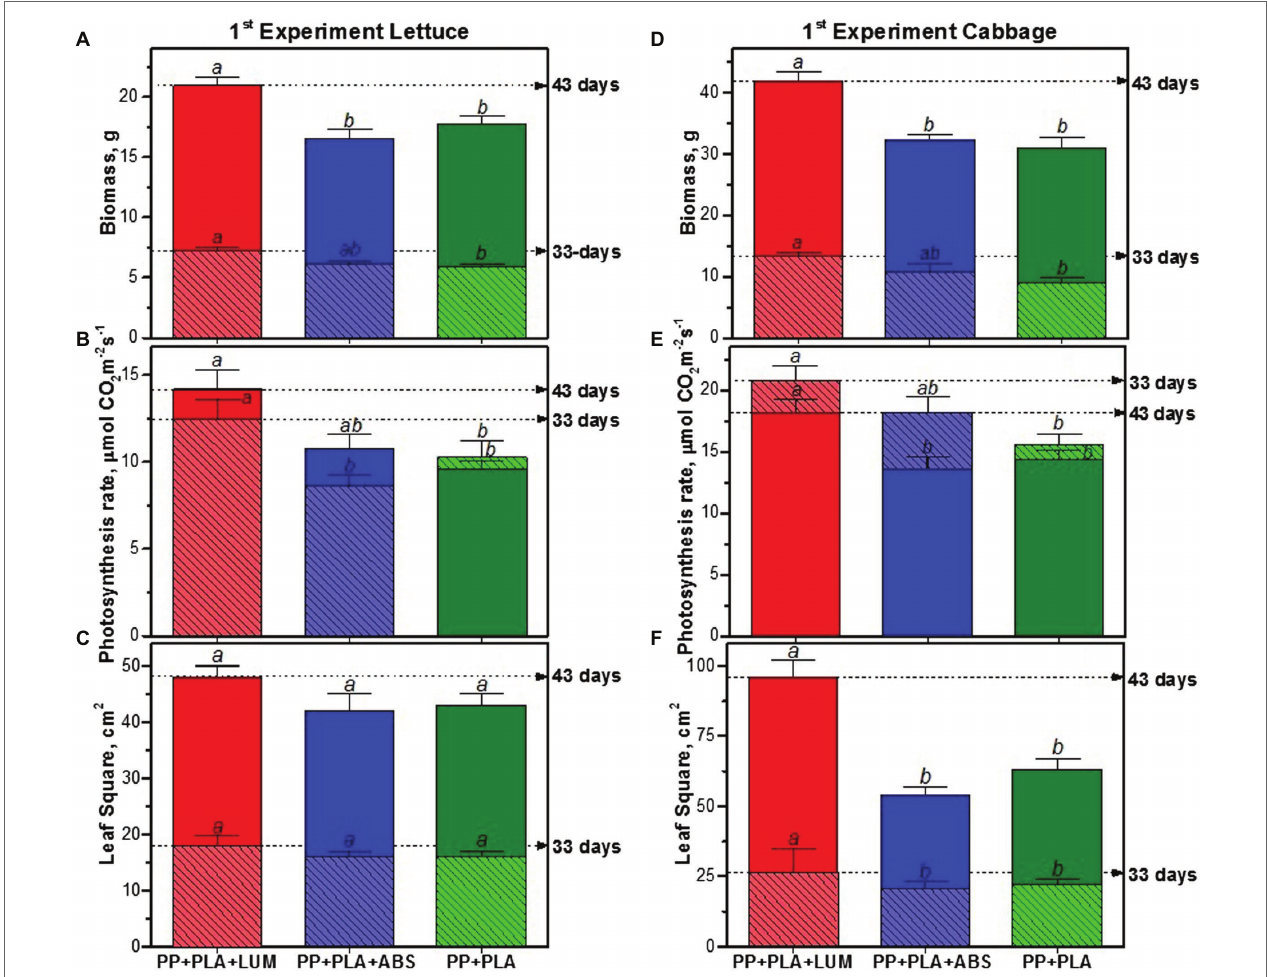
FIGURE 5 | Experiment 1. Biomass accumulation (A,D) , photosynthesis rate (B,E) , and average leaf area (C,F) of lettuce and cabbage, respectively, grown for 33 days (columns marked with light tone and shading) and 43 days (standard columns) under agro textiles: PP + PLA + LUM, PP + PLA + ABS, and PP + PLA. Mean values ± SE are given. The values indicated in a row by different letters (a or b) significantly differ from each other ( p <